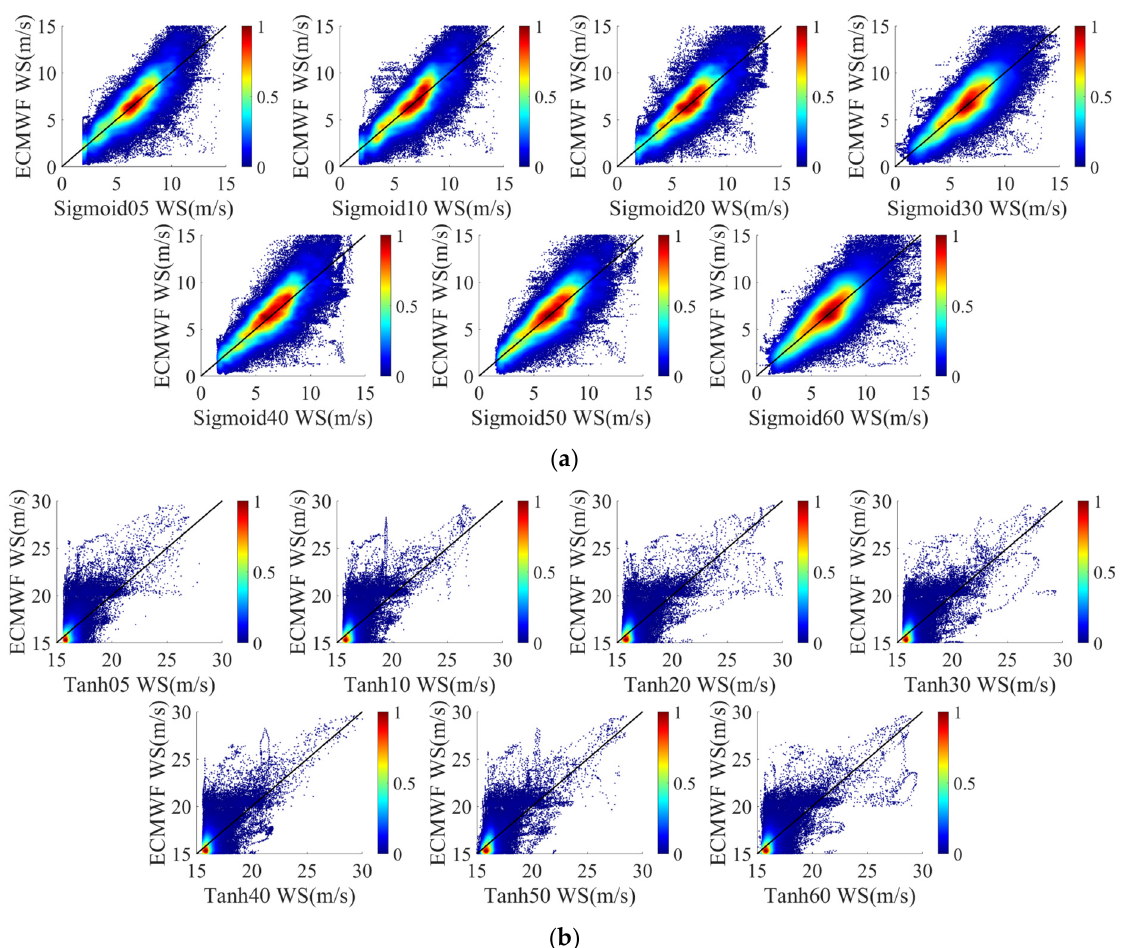
Figure 9. ( a ) ANN scatter plot with the activation function Sigmoid in the low wind speed interval. ( b ) ANN scatter plot with the activation function Tanh in the high wind speed interval.